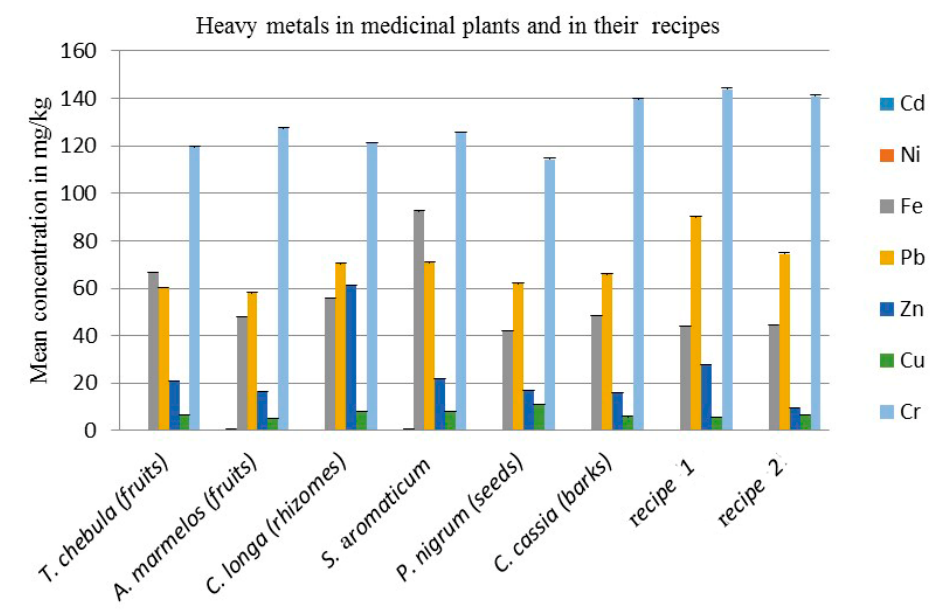
Figure 1. Meanconcentrationofheavymetalsinmg / kginmedicinalplantsandintheirrecipes. Eachcolumn represents the mean value of three independent replicates and the error bars indicate standard deviation.